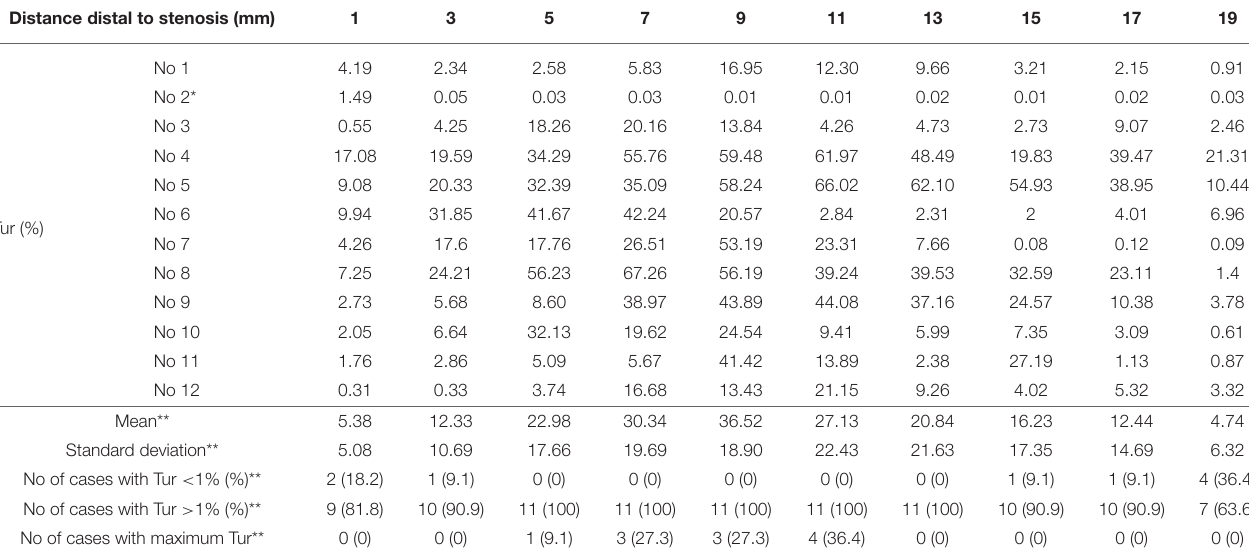
TABLE 3 | Tur indices (%) distal to a 70% stenosis in 12 canine femoral arteries. Distance distal to stenosis